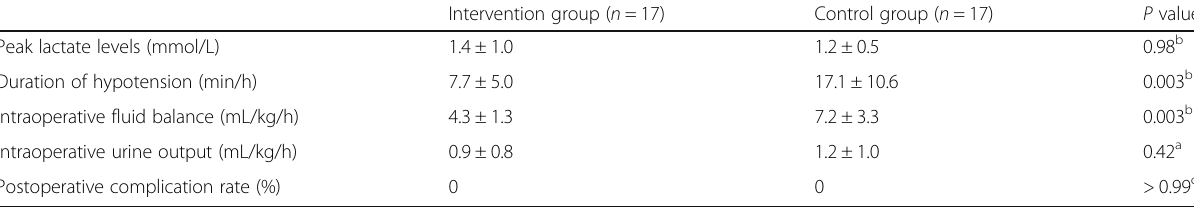
Table 2 Primary and secondary